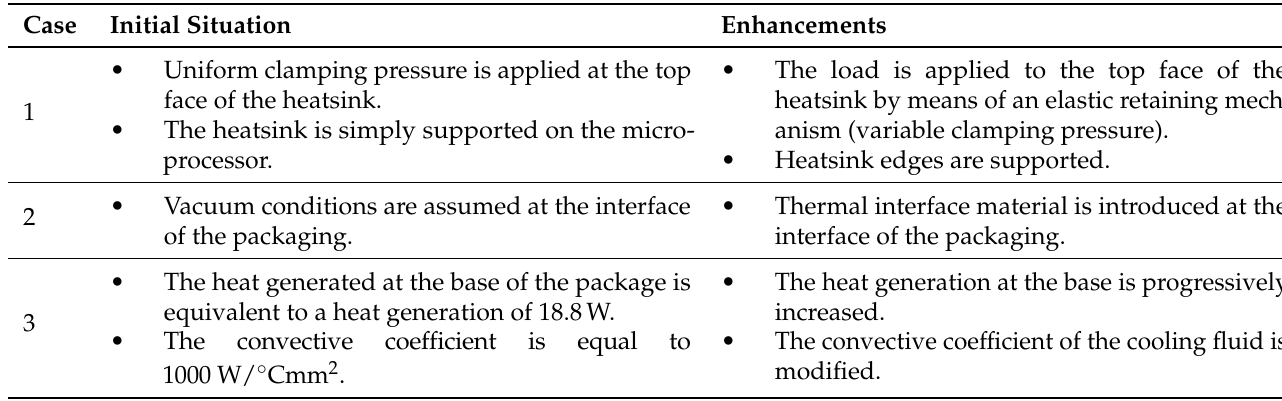
Table 1. Case study summary.